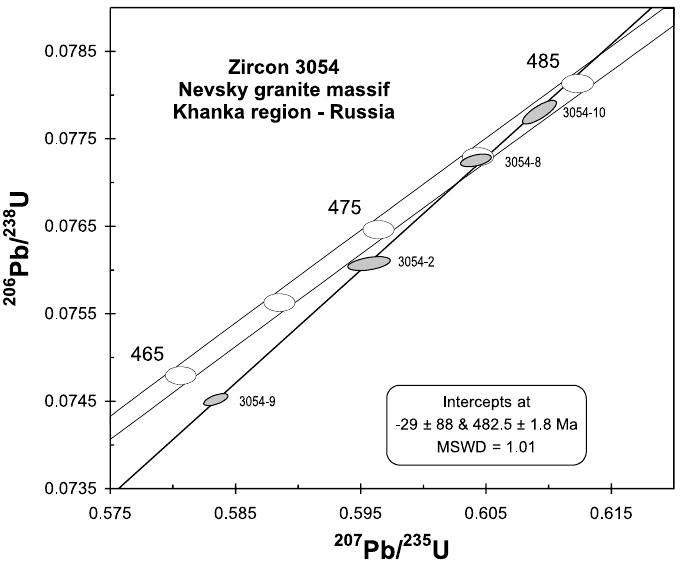
Fig. 5 – The U-Pb concordia diagram for zircon 3054 (Nevsky granite massif) using 235 U- 205 Pb “ B”